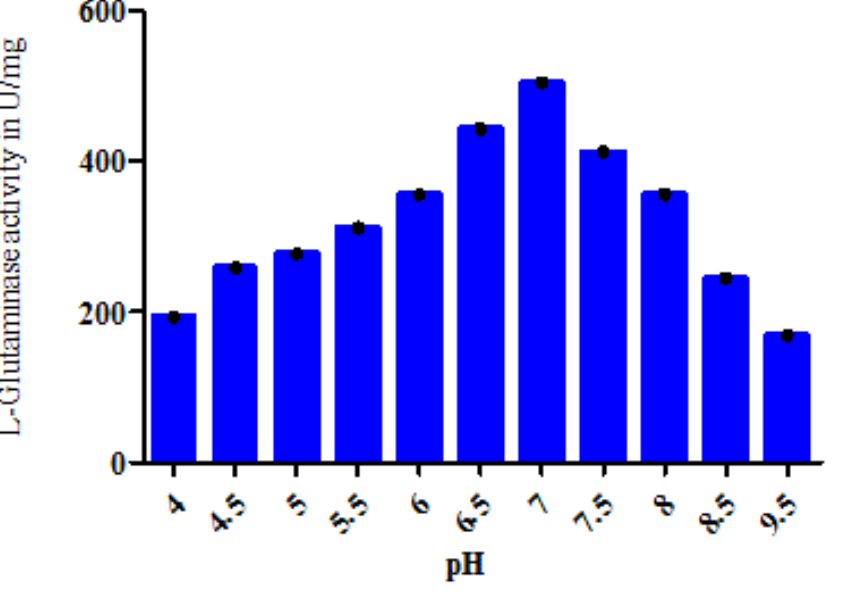
Figure 12. Effect of pH on L-glutaminase activity produced by A. xylosoxidans RSHG1 at 37 °C.